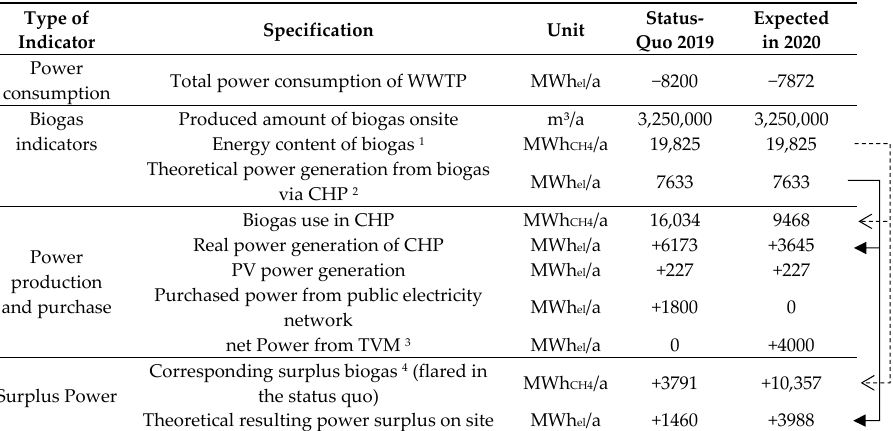
Table 1. Energetic situation based on annual average values of the WWTP Mainz before and after the start of operation of the sludge incineration plant.